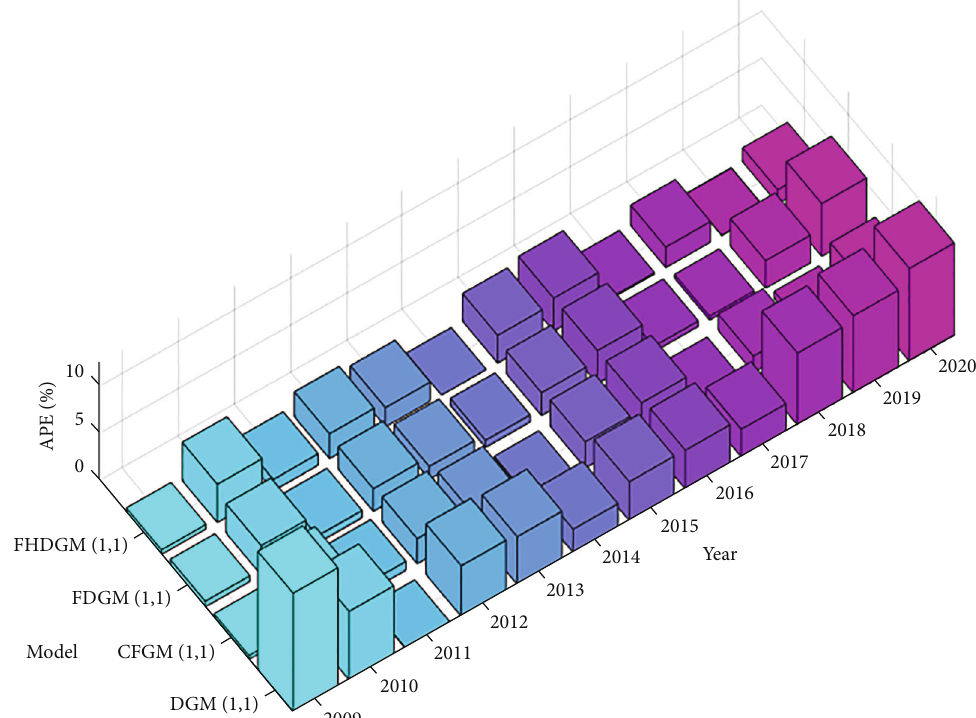
Figure 8: APE of prediction of total European renewable energy